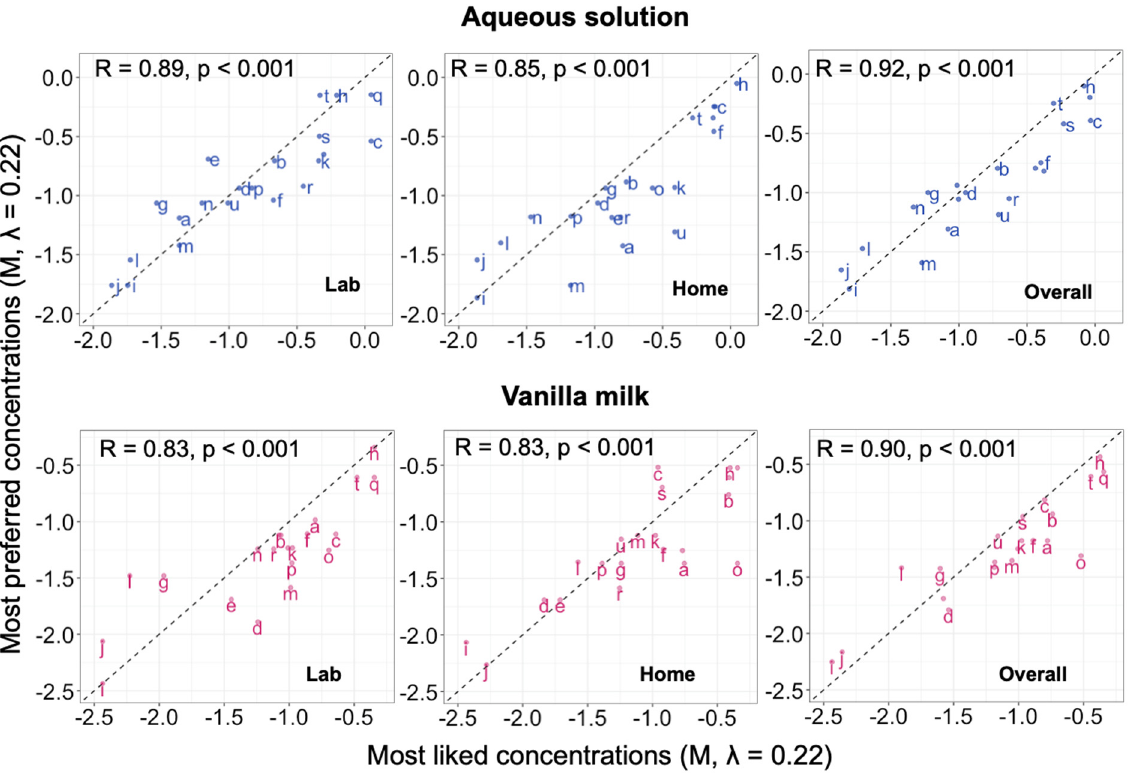
Figure 2. Scatter plots for optimal sucrose concentration estimated via paired-comparison preference tracking (most preferred, averaged across replicate sessions) vs. optimal concentration estimated from ratings of liking (most liked). Values are Box-Cox transformed ( λ = 0.22) sucrose concentrations (M). The letters on the plot represent participant ID. Top (blue points): data for aqueous solutions. Bottom (pink points): vanilla milk. Left to right: measured in the laboratory, measured at home, and averaged across the two test locations (overall). Dotted line: line of equality (y = x